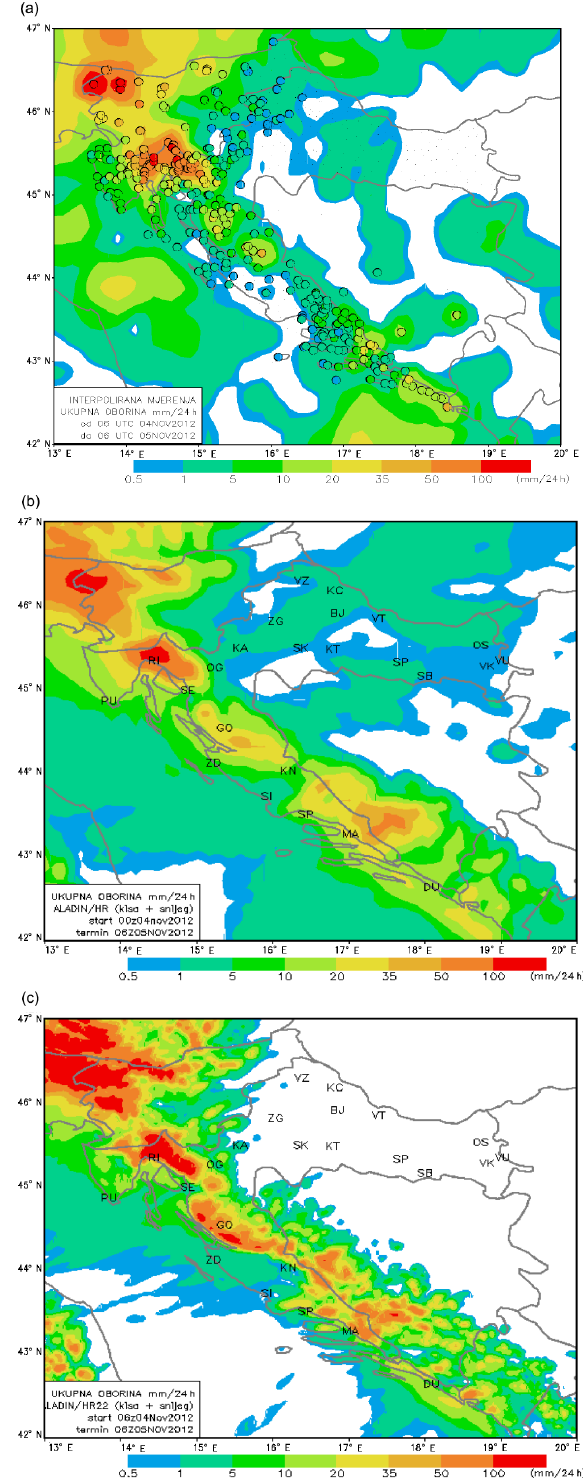
Figure 9. Same as Fig. 5 but for IOP19 (4